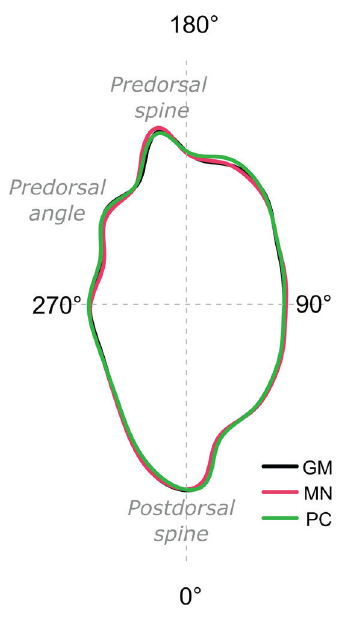
FIGURE 5 | Otolith’s contour reconstruction (Fourier). GM = Stellifer gomezi , MN = S. menezesi , PC = S. punctatissimus